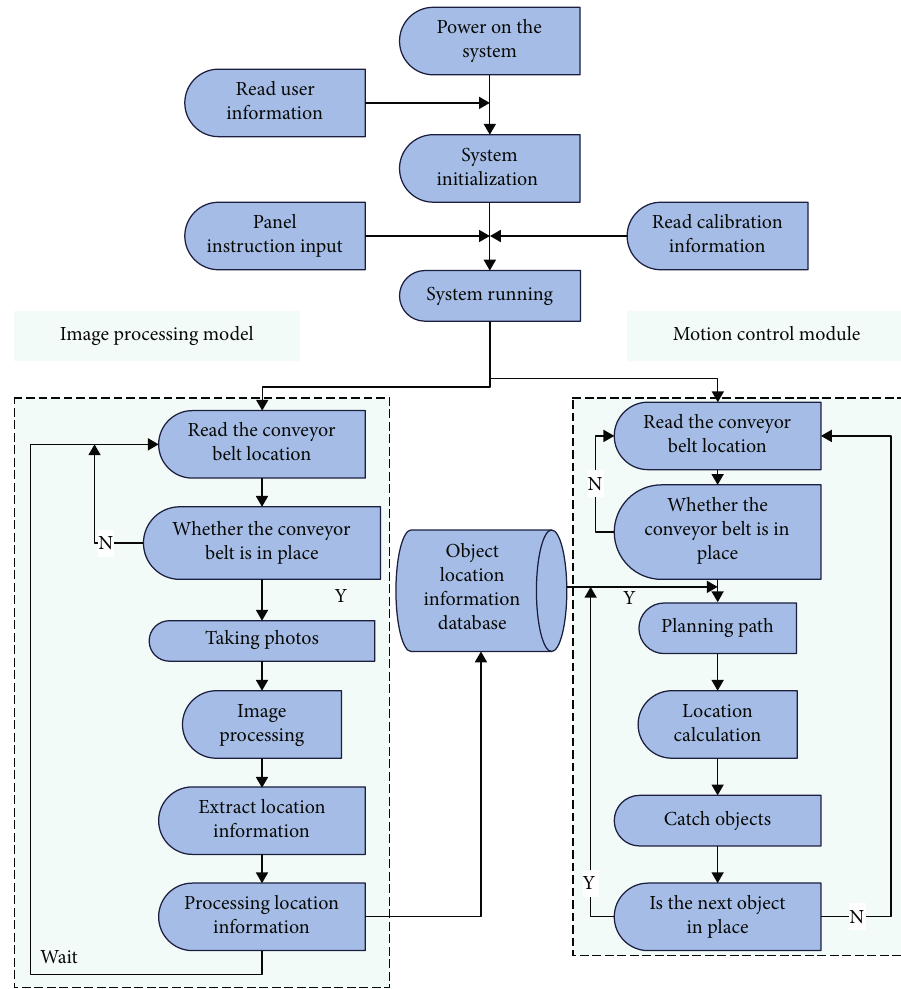
Figure 4: Software structure of the control